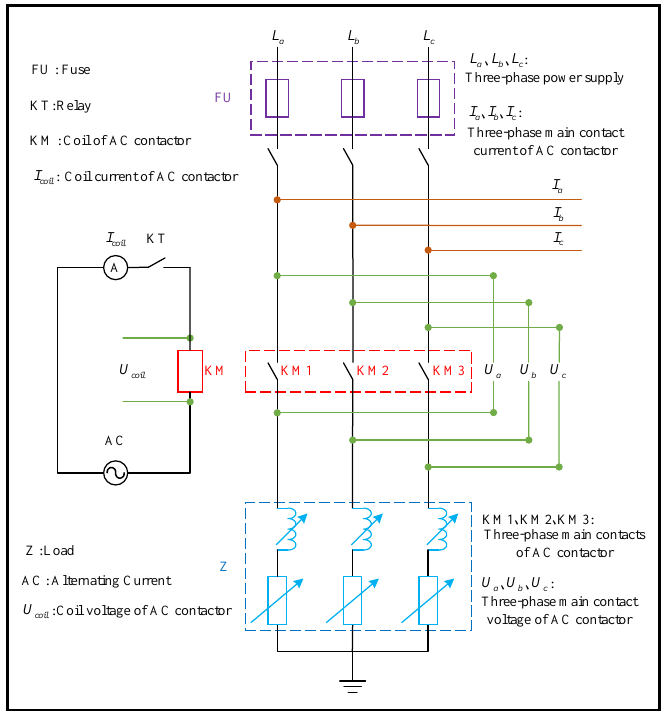
Figure 6. Electrical